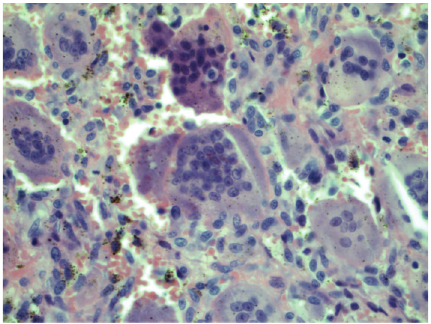
Figure 7: Microscopic pathology: H-E stain at 200x at the lesion of the right femur: the specimen demonstrated large osteoclasts and uniform mononuclear cells with ovoid nuclei, giant cells containing about 50 to 100 nuclei, and ill-defined cytoplasm with very few intercellular